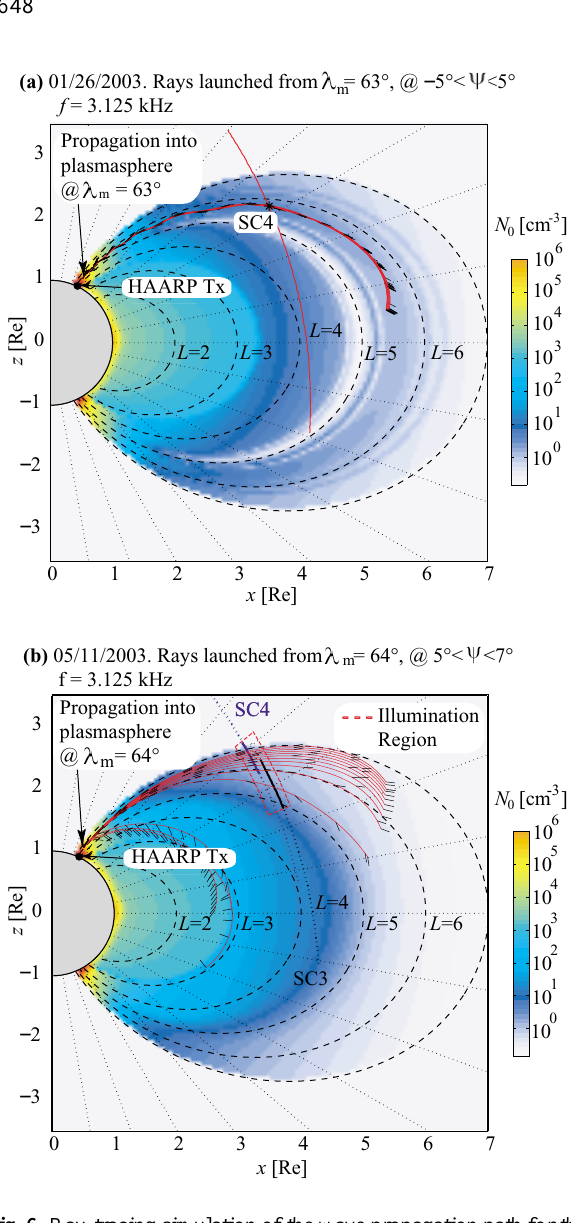
Fig. 6. Ray-tracing simulation of the wave propagation path for the two dates studied. Panel (a) shows ray paths from the simulation corresponding to 26 January 2003. Panel (b) shows ray paths from the simulation corresponding to 11 May 2003. Rays were launched at 3.125kHz from different latitudes on the ground, at locations near the HAARP facility and for different wave normal angles at the launching point, where the wave is injected into the magnetosphere. The color scale represents the value of plasma density as measured from WHISPER and projected into the 2-D meridional plane using a diffusive equilibrium model in the plasmasphere and an R − 4 in the magnetosphere outside the plasmasphere. Also plotted is the trajectory of the spacecraft and the region where the HAARP signal was detected. The ray paths are displayed as a thin red line, and the direction of the k vector is shown as a short black line periodically spaced along the path. Notice the location of the HAARP facility with respect to the point of injection of the wave into the magneto- sphere.